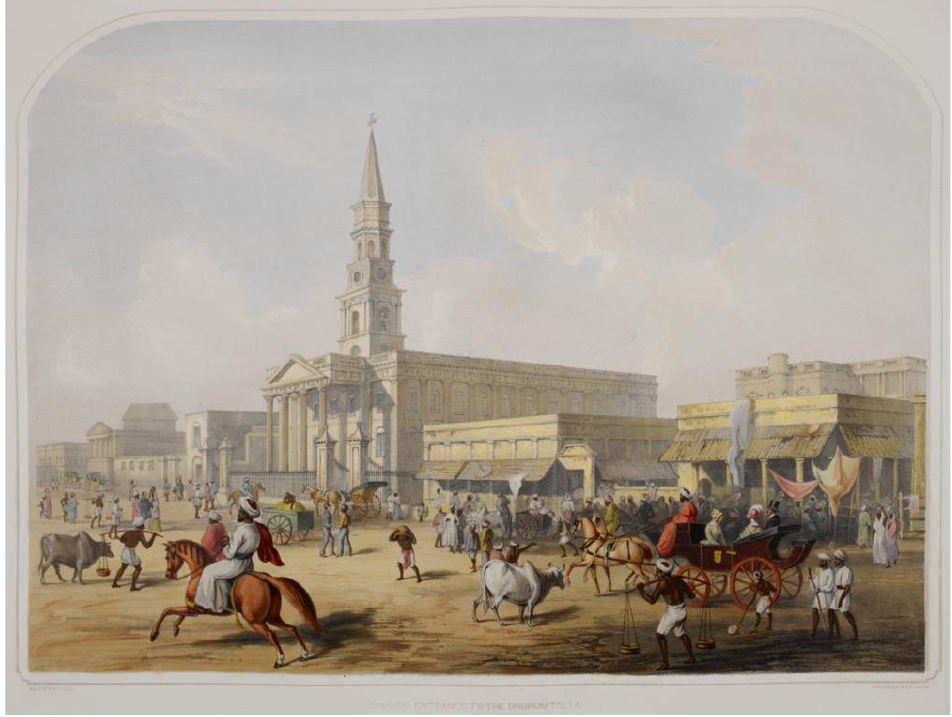
C harles D’Oyly, “Curch. Entrance to the Dhurumtolla,” 1848, (Views of Cal cutta and its Environs) © The British Library Board (X 666, Plate